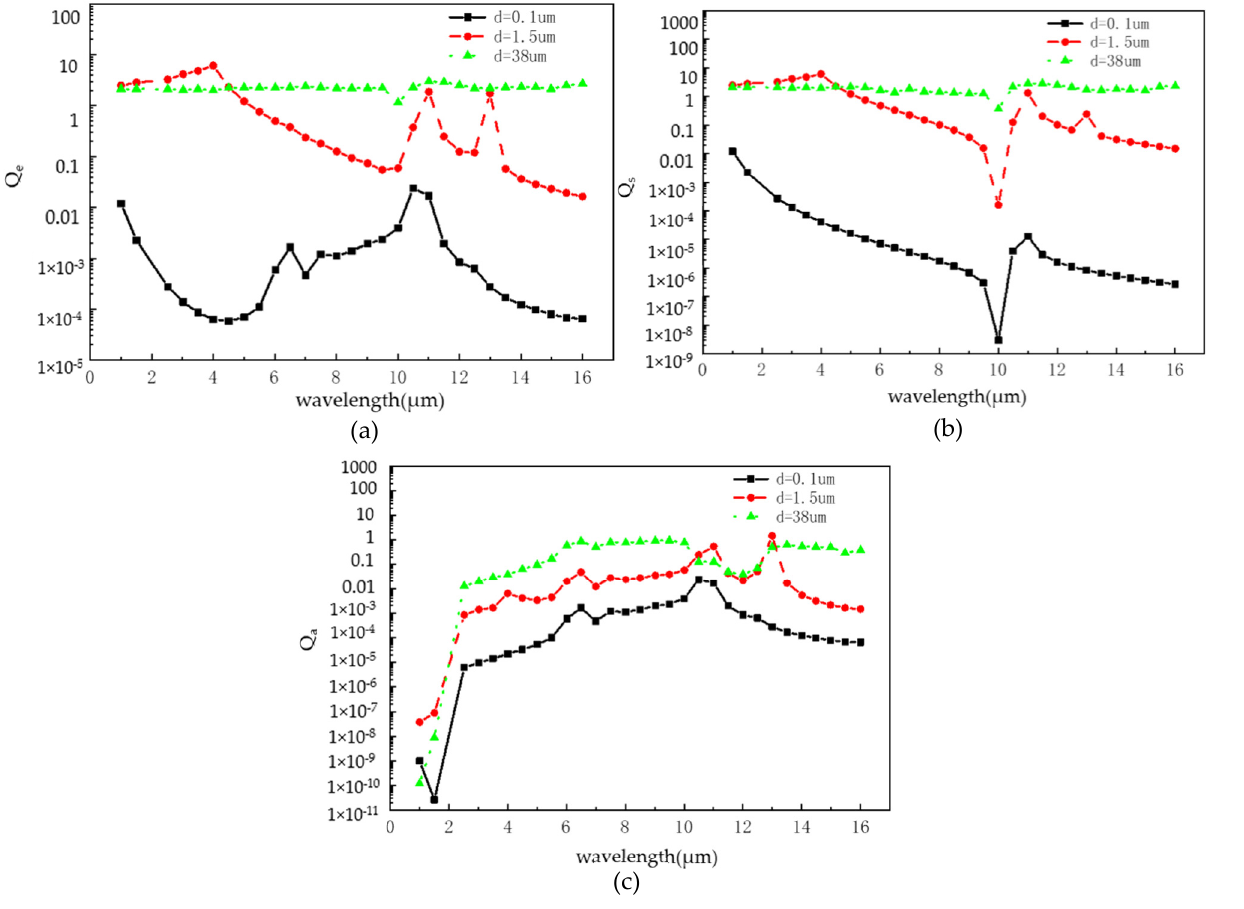
Figure 4. The extinction factor, scattering factor and absorption factor of SiC particles with different scale changes at different wavelengths: ( a ) extinction factor (Q e ); ( b ) scattering factor (Q s ); ( c ) absorption factor (Q a ).